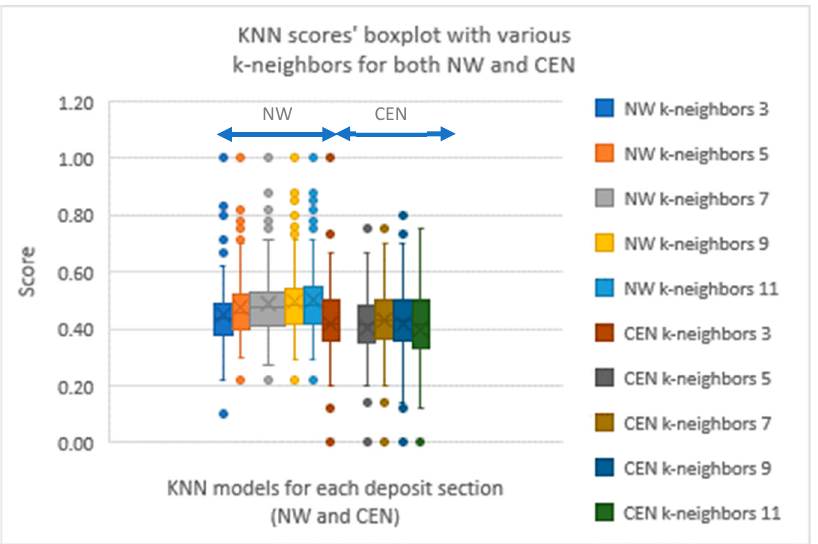
Figure 5. Box plots of results in various k-numbers on KNN performance in both NW and CEN.